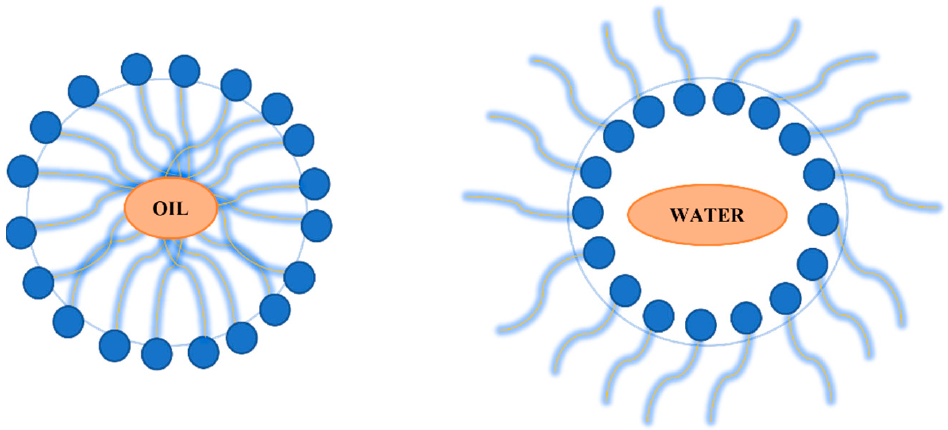
Figure 4. Oil in water micro-emulsification versus water in oil micro-emulsion.